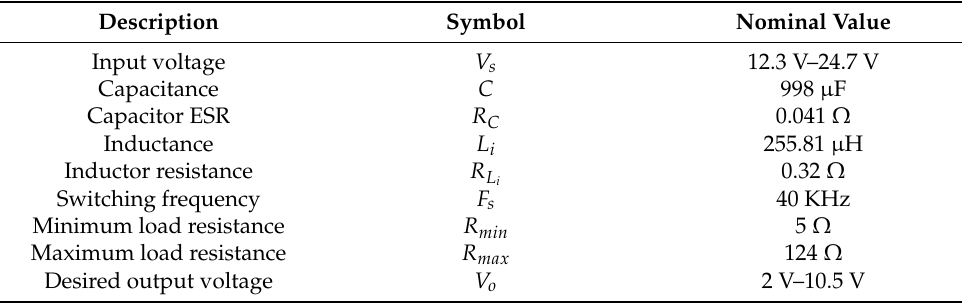
Table 2. Specifications of a synchronous buck converter measured at 10